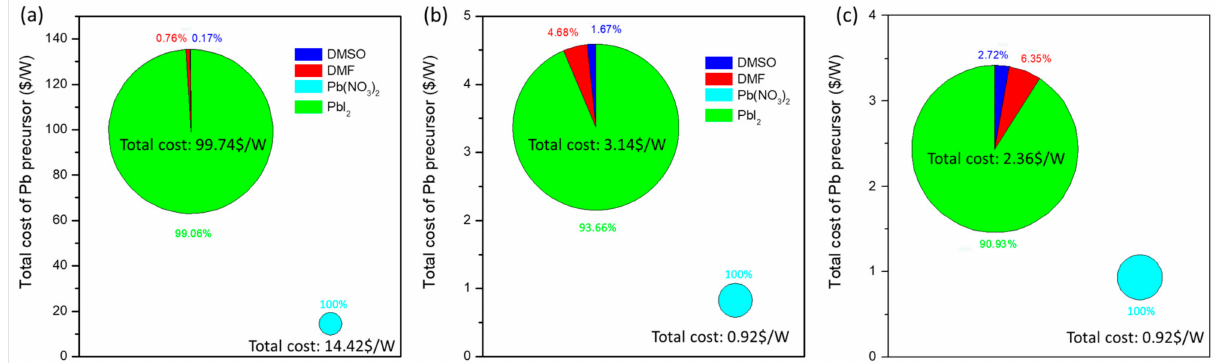
Figure 7. Cost analysis of lead precursor ( a ) based on our results and academic research; PCE = 10.75% for PSM_PbI 2 ; PCE = 13.1% for PSM_Pb(NO 3 ) 2 . ( b ) Based on industrial production PCE = 15% for both of PSM_PbI 2 and PSM_Pb(NO 3 ) 2 . ( c ) Based on industrial production PCE = 20% for PSM_PbI 2 and PCE = 15% for PSM_Pb(NO 3 ) 2